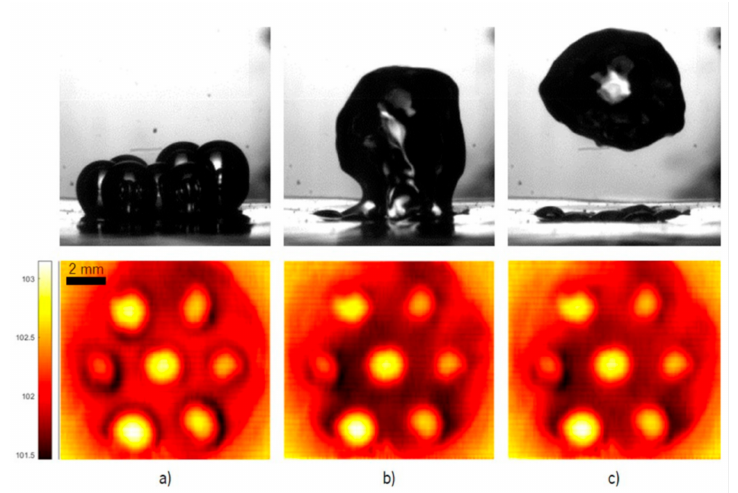
Figure 8. Synchronized images of the dynamic evolution between seven bubbles with spacing δ = 1 d and the respective thermographical images. The imposed heat flux is 2132 W/m 2 , and the fluid is Ag 1%. ( a – c ) Conditions before, during and after coalescence,